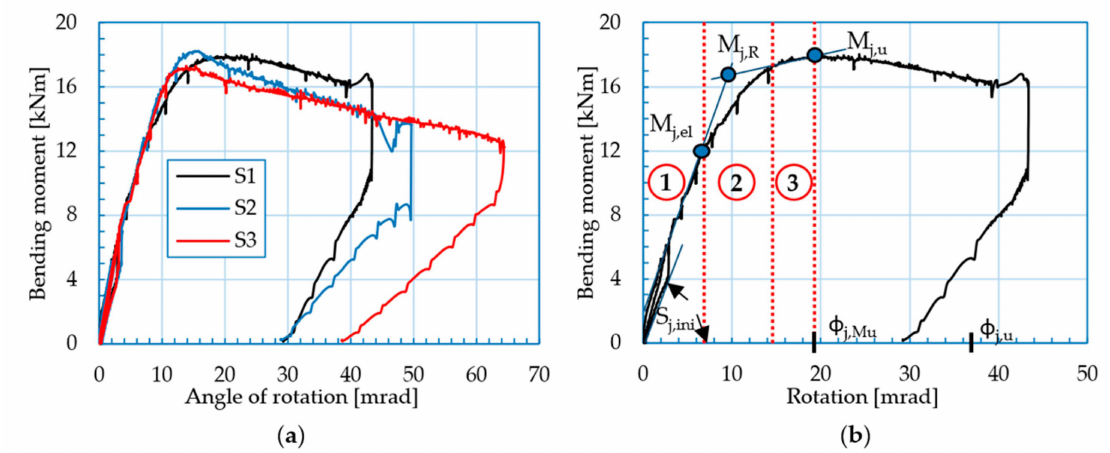
Figure 9. Moment–rotation curves: ( a ) rotational behaviour of specimen S1–S3; ( b ) main properties of the M j – φ j